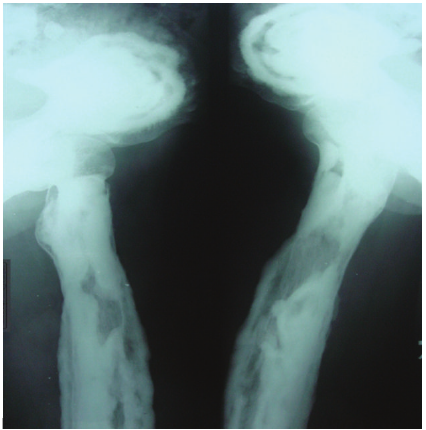
Figure 10: Anteroposterior view of the hip joint showed generalised sclerosis of the pelvic rami and the femur bone.